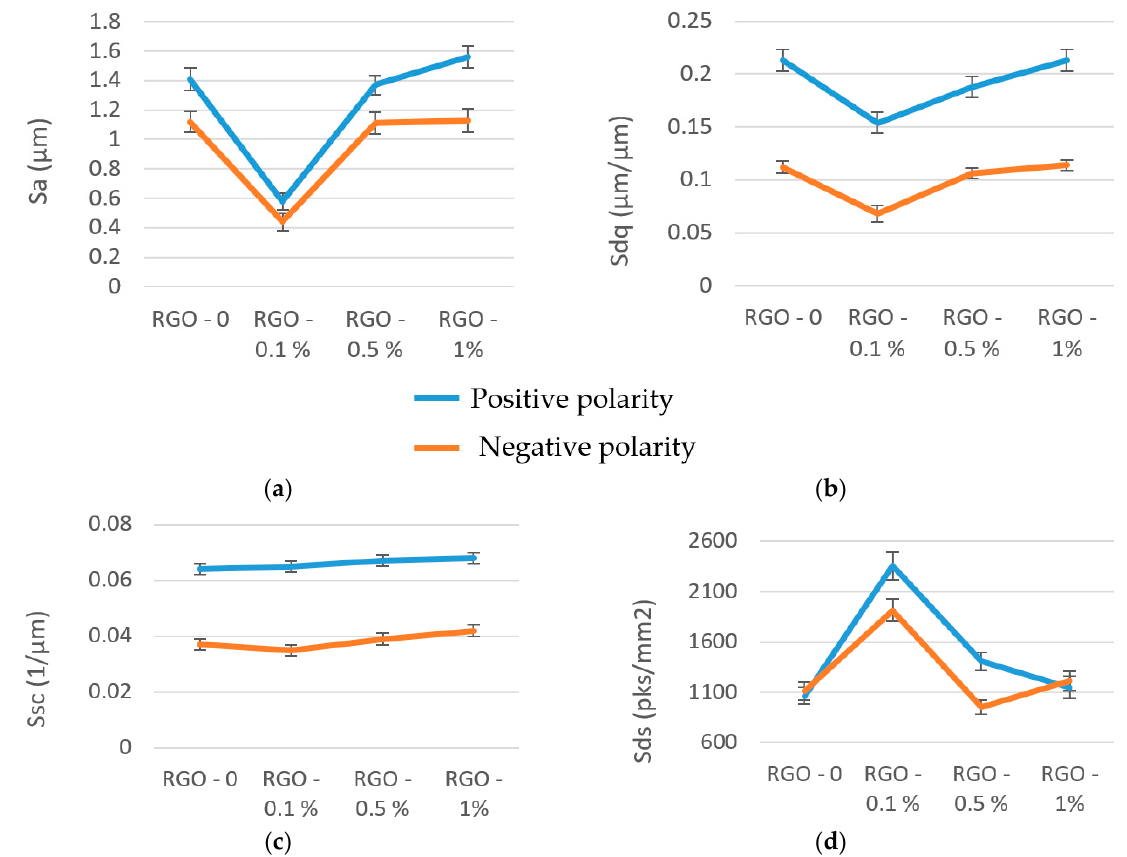
Figure 7. The surface roughness parameters after PMEDM of the tool steel 55NiCrMoV7 with positive and negative polarity: ( a ) Sa ; ( b ) Sdq ; ( c ) Ssc ; ( d ) Sds . and negative polarity: ( a ) Sa ; ( b ) Sdq ; ( c ) Ssc ; ( d ) Sds